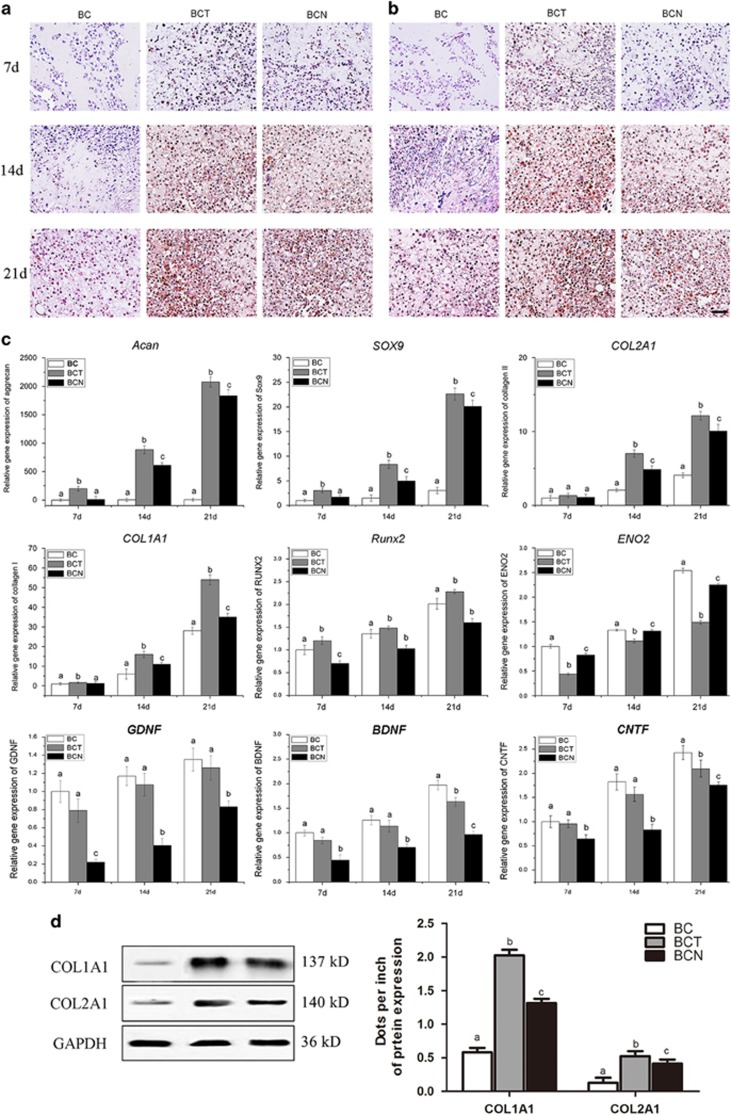
Chondrogenic effects of NGF on BMSCs grown in 3D cultures. (a and b) Immunohistochemical staining of COL1A1 (a) and COL2A1 (b) was performed in the cultured constructs on days 7, 14 and 21. (c) qRT-PCR was performed to determine the expression levels of ACAN, SOX9, COL2A1, COL1A1, RUNX2, ENO2, GDNF, BDNF and CNTF in the cultured constructs on 7 14 and 21 day. (d) Western blots was used to analyze the protein expression levels of Col1A1 and COL2A1. The values are means±S.D., n=6; bars with different letters are significantly different from each other at P<0.05, Scale bar=100 μm